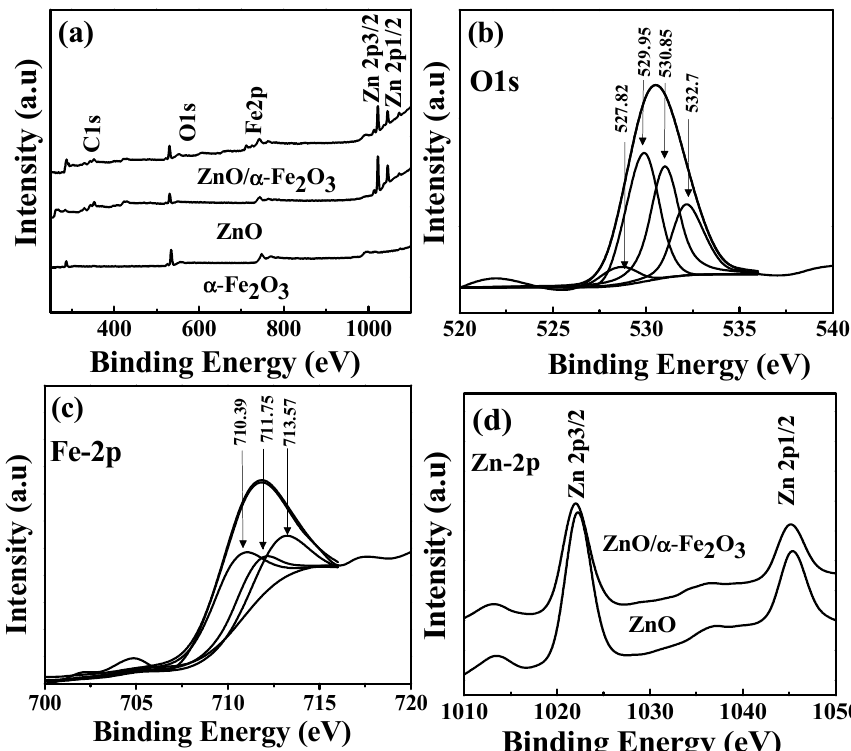
Figure 5. XPS survey spectra of ( a ) α -Fe 2 O 3 , ZnO and ZnO / α -Fe 2 O 3 (3 wt%); ( b ) O1s (ZnO / α -Fe 2 O 3 ); ( c ) Fe-2p (ZnO / α -Fe 2 O 3 ); and ( d ) Zn-2p binding energy spectra of ZnO and ZnO / α -Fe 2 O 3 .